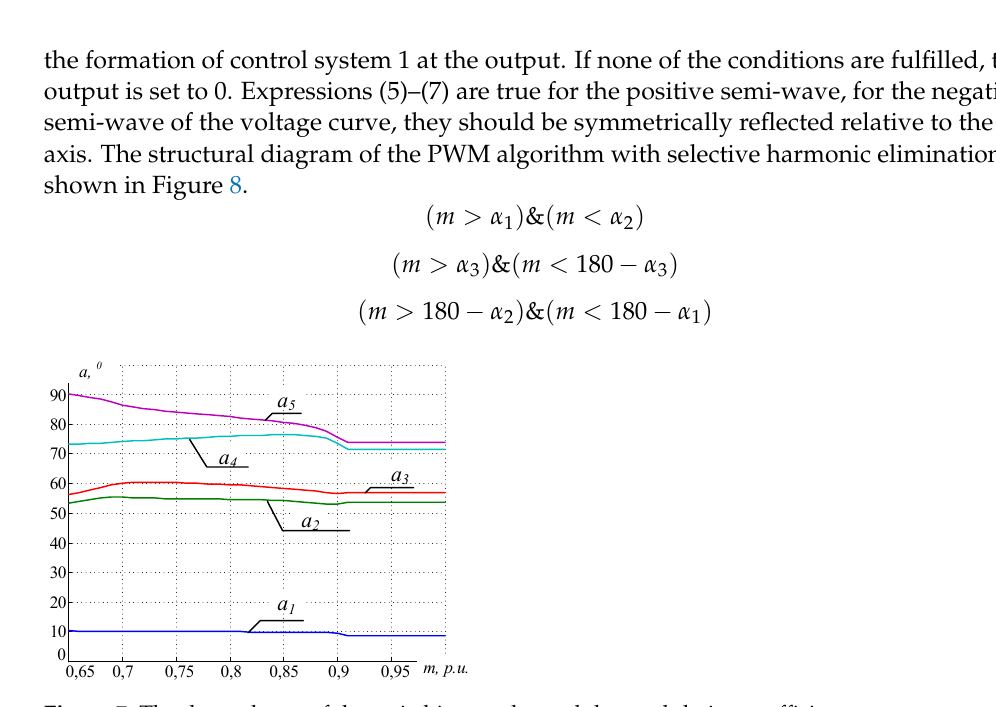
Figure 7. The dependency of the switching angles and the modulation coefficient.